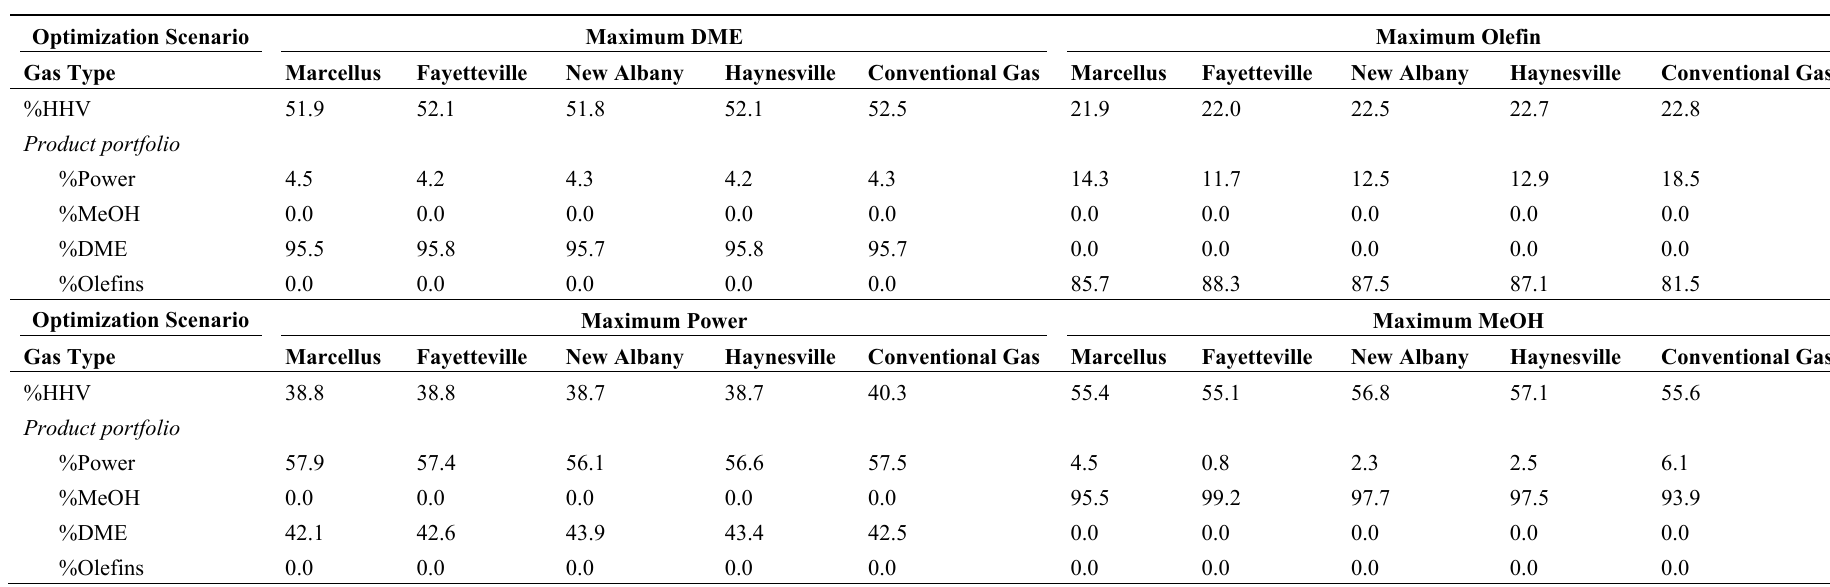
Table 8. Comparison of the thermal analysis results of different shale gases with NiO-CLC as the selected power generation